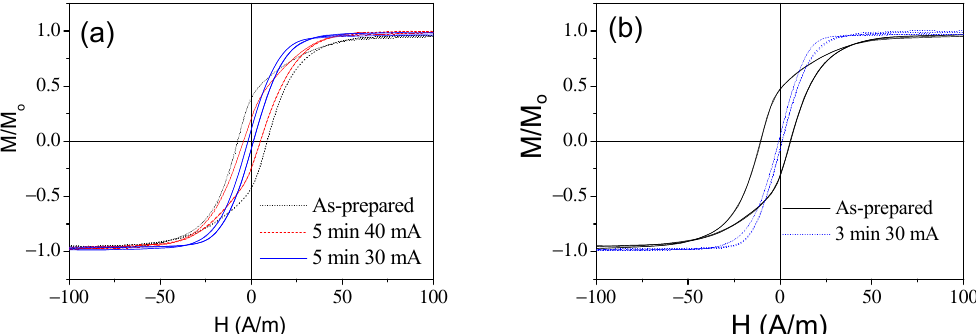
Figure 22. Hysteresis loops of as-prepared and current annealed at 30 mA and 40 mA for 5 min ( a ), 3 min and 30 mA ( b ) Co 67 Fe 3.9 Ni 1.5 B 11.5 Si 14.5 Mo 1.6 amorphous glass-coated microwire. (Reproduced with permission from [26] Copyright © 2019 Elsevier B.V).